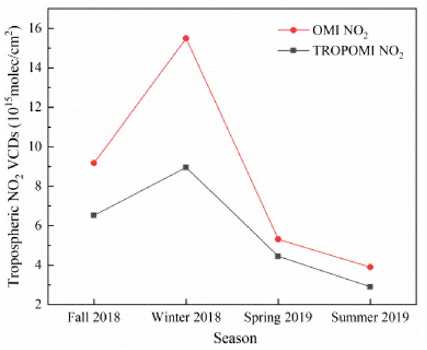
Figure 6. Seasonal variation trend of NO 2 VCDs of the COVID-19 early period from August 2018 to September 2019 in Henan